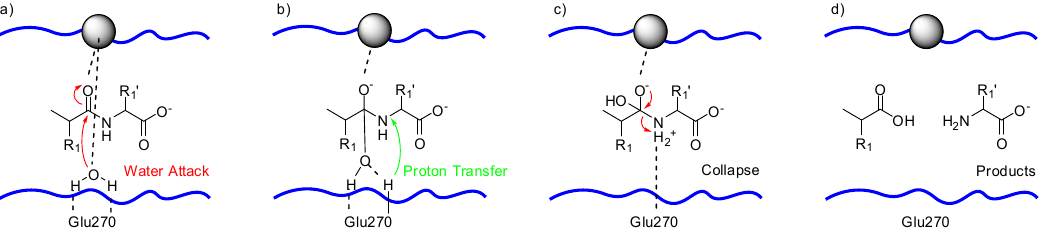
Figure 2. Proposed mechanism for the catalyzed hydrolysis of peptide bonds by carboxypeptidase A: ( a ) nucleophilic attack of the water molecule, ( b ) proton transfer to the substrate, ( c ) collapse of the intermediate results in ( d ) the formation of the products, zinc (II) ion depicted as gray sphere; based on Matthews [66].